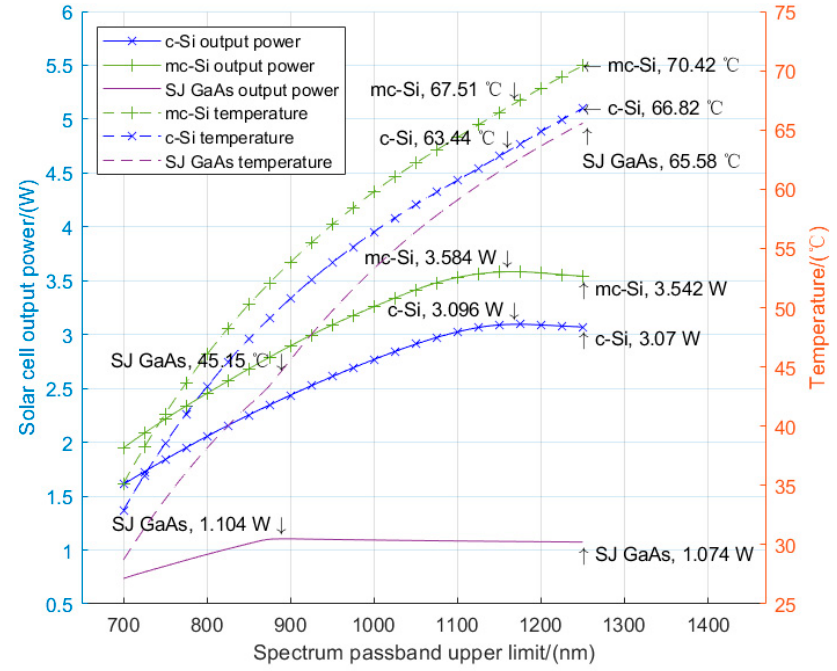
Figure 6. Relationship between long-wave cut-off filter passband and solar cell characteristics.